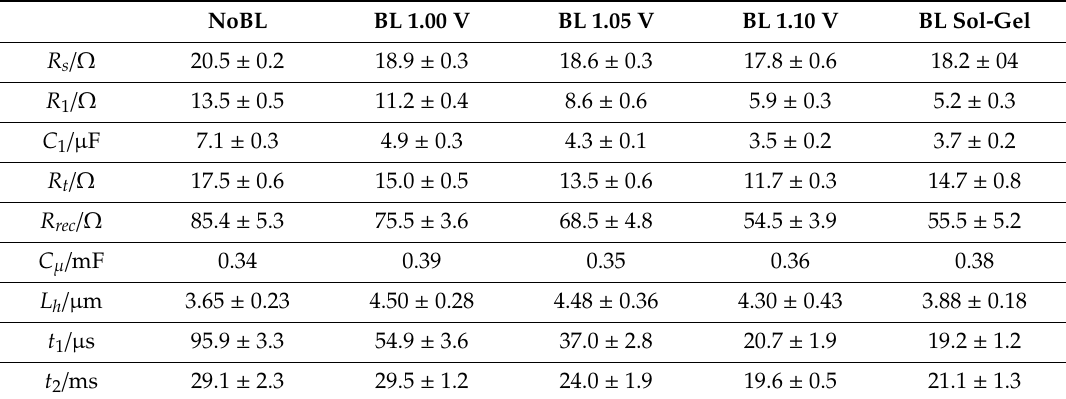
Figure 4. Electrochemical Impedance spectra of Dye-Sensitized Solar Cells made with or without (black dots) a blocking layer. The latter is electrochemically deposited at 1.00 V (red squares), 1.05 V (blue diamonds), 1.10 V (green triangles), or deposited by sol-gel (orange triangles). EIS spectra are reported in both the Nyquist (on the left) and Bode (on the right) representation. The insert is a zoom of the high-frequency domain to highlight the downsizing of the first semicircle. Table 3. Photoelectrochemical parameters obtained from the interpolation of the experimental point of EIS spectra.